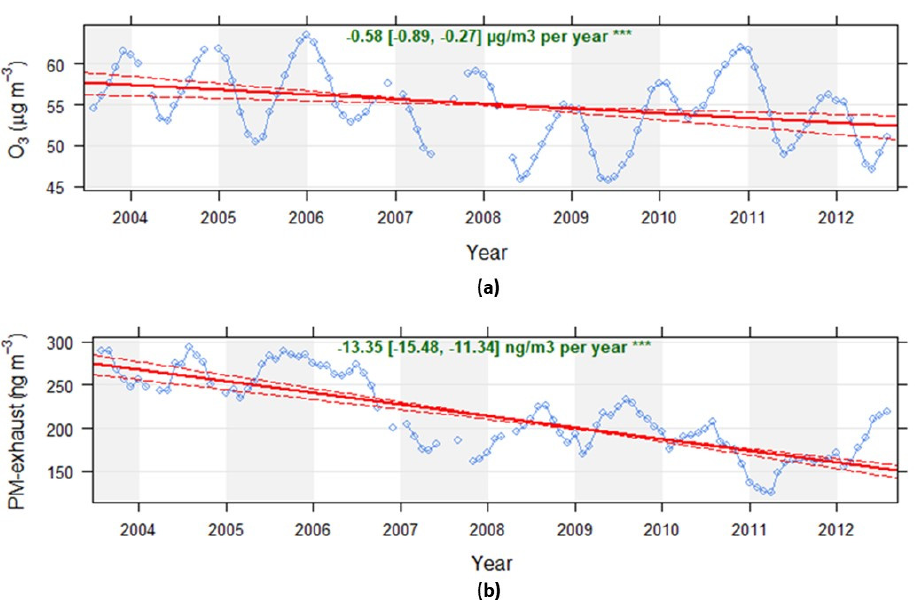
Figure 1. Calculated monthly mean exposure concentrations of ozone (a) and exhaust particles (b) for all mothers and all trimesters included in the study. The trends are based on monthly mean values with at least 75% data capture. The Openair package “TheilSen” function in R accounting for autocorrelations and bootstrap simulations have been used to obtain the trends (*** means p < 0.001).